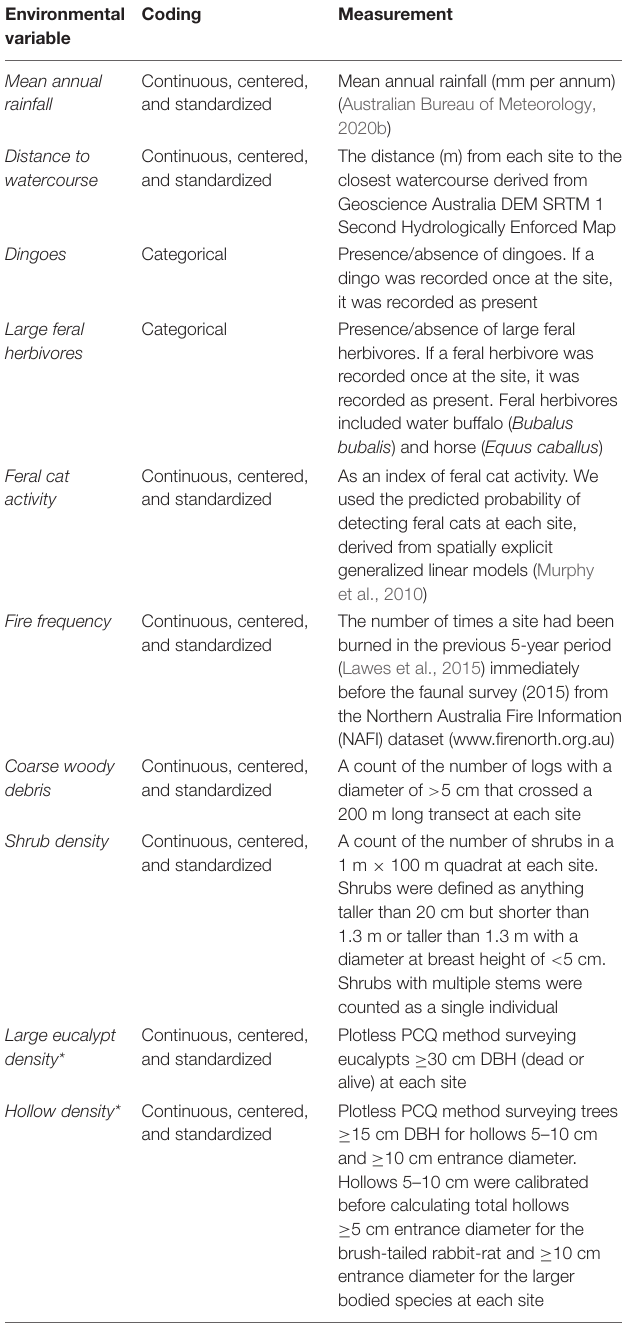
TABLE 1 | Description of the variables used in the analyses to assess the correlates of Melville Island arboreal mammal distribution in